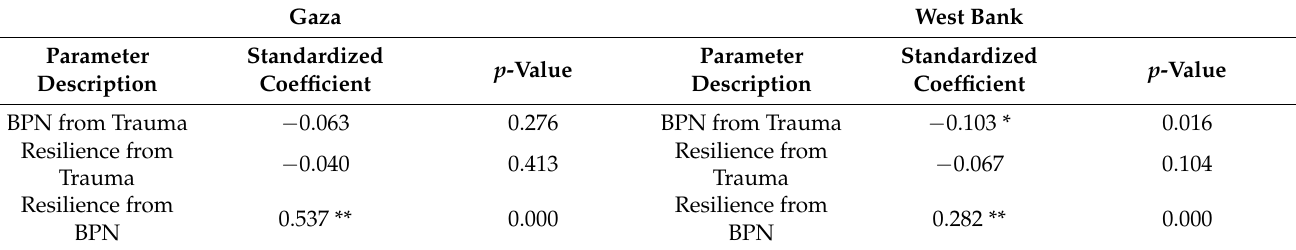
Table 3. Standardized regression weights and correlation coefficients for the interaction model (sec- ond model).